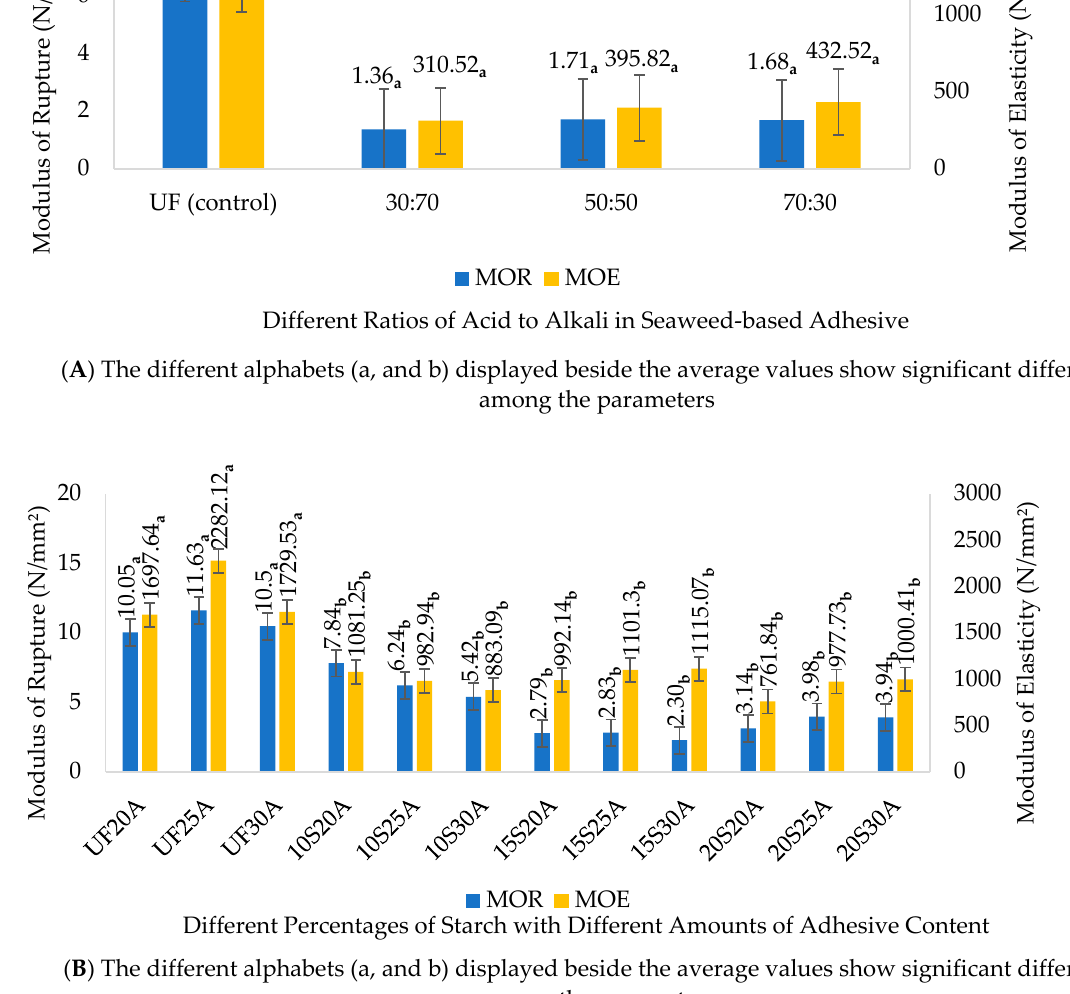
Figure 4. Average MOE and MOR for ( A ) seaweed-based adhesive particleboard. ( B ) starch-based adhesive particleboard.